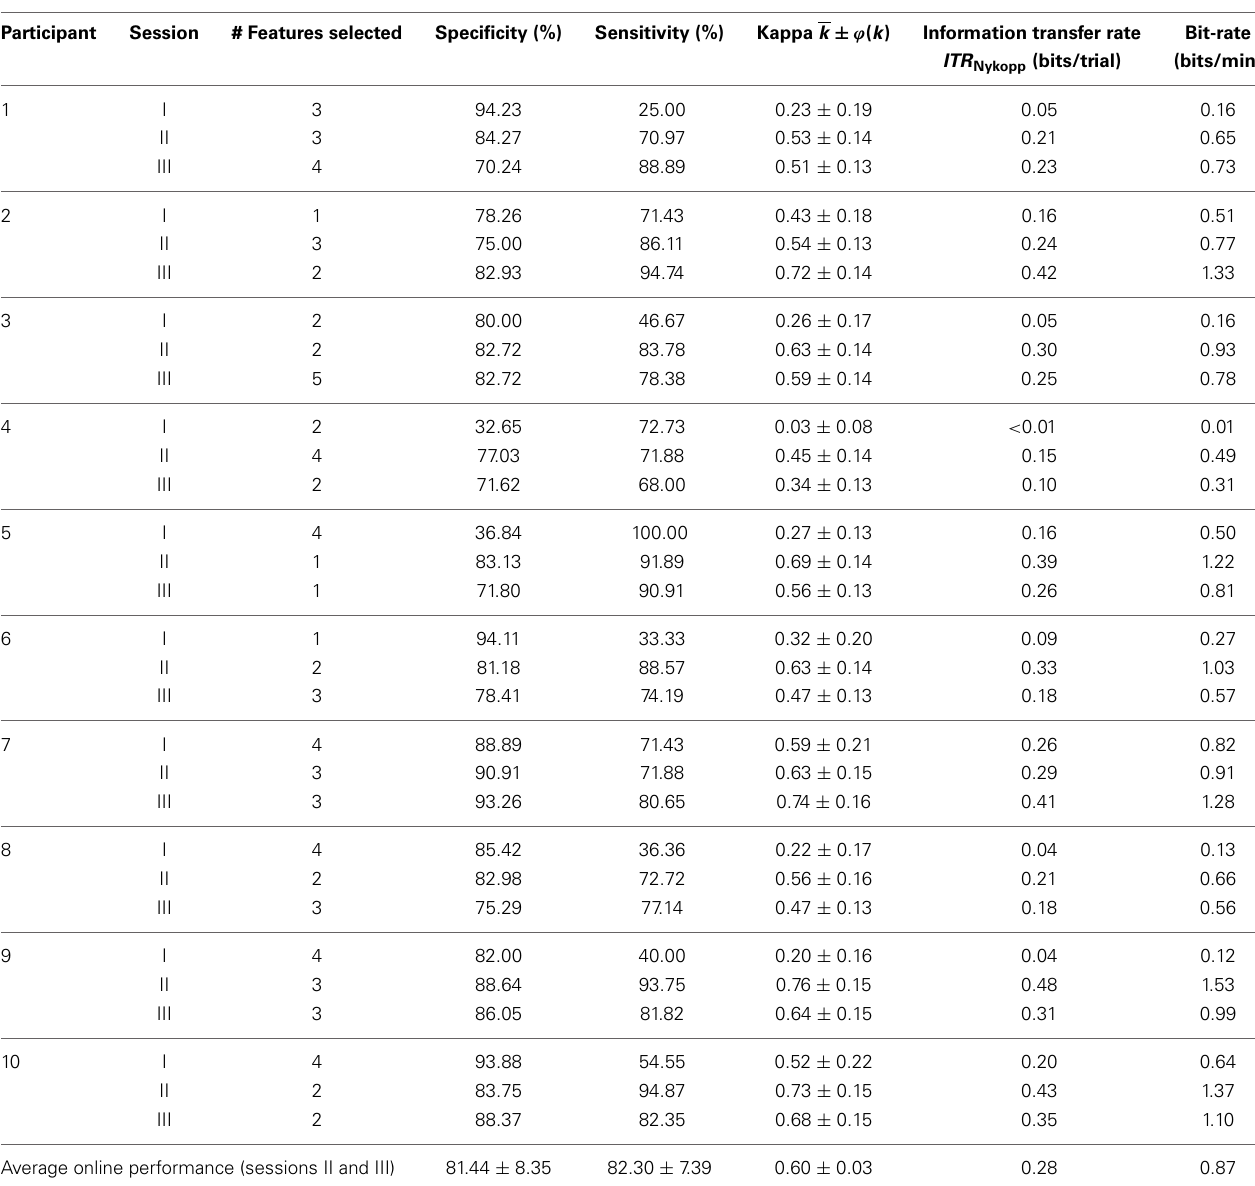
Table 1 | Classification performance within individual sessions.